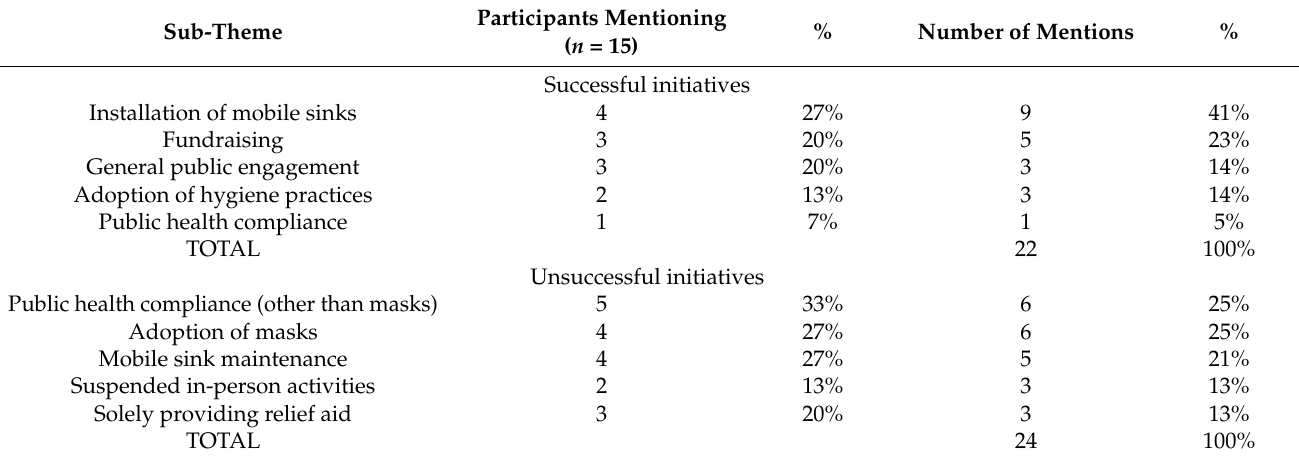
Table 10. Initiatives perceived as successful vs.